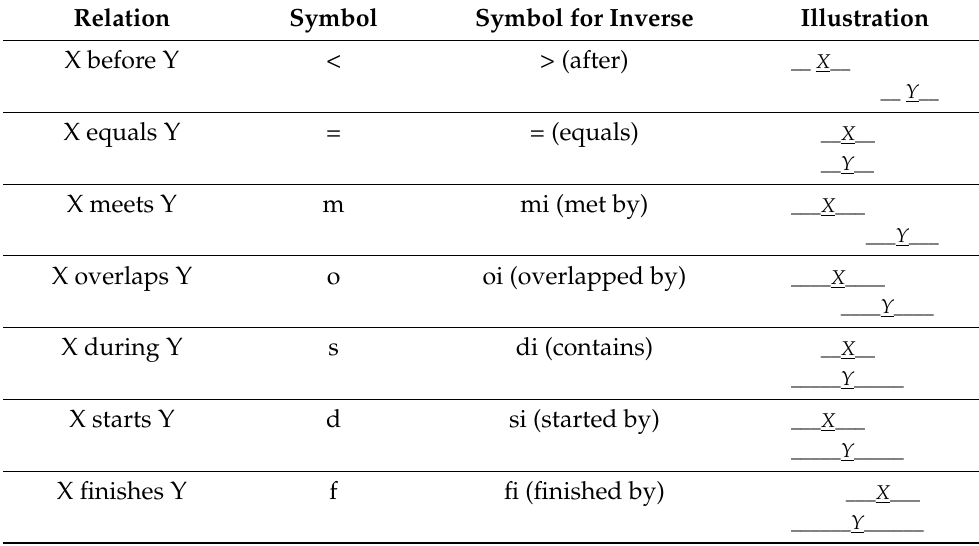
Table 4. Allen’s temporal